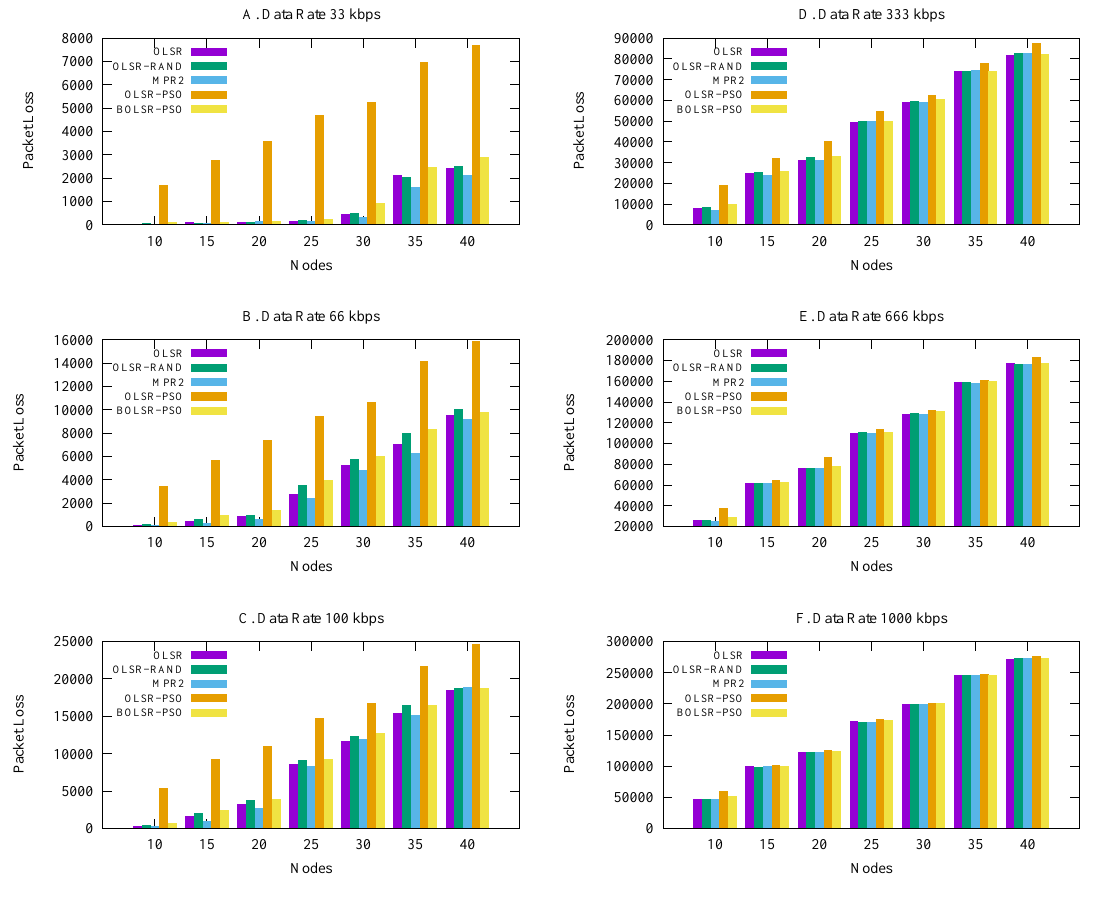
Figure 6. Packet Loss vs. Number of Nodes.